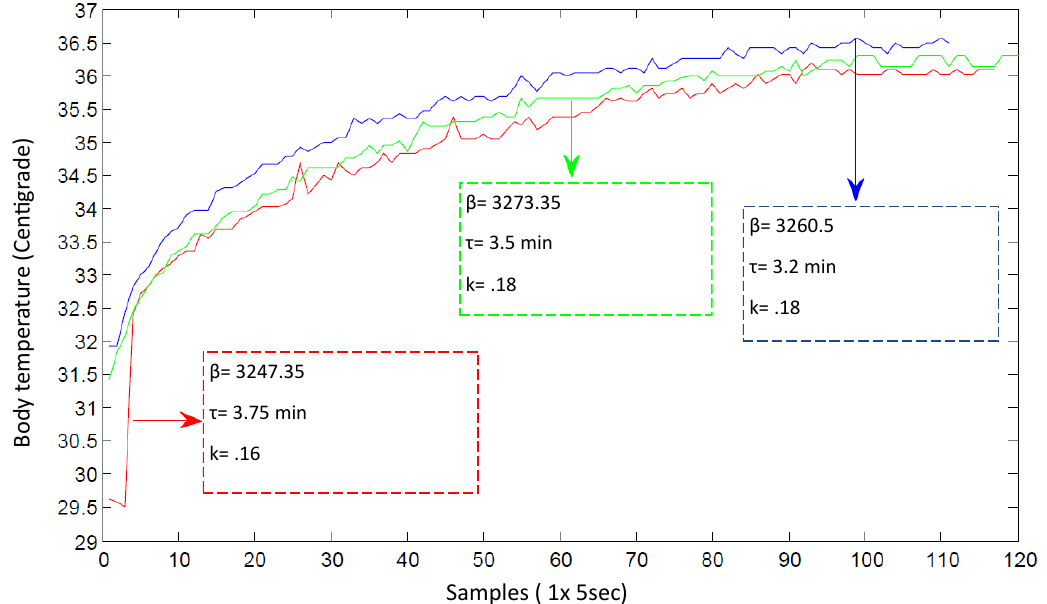
Figure 13. BT measurement trials with different β values to determine the response time of the BT prototype.